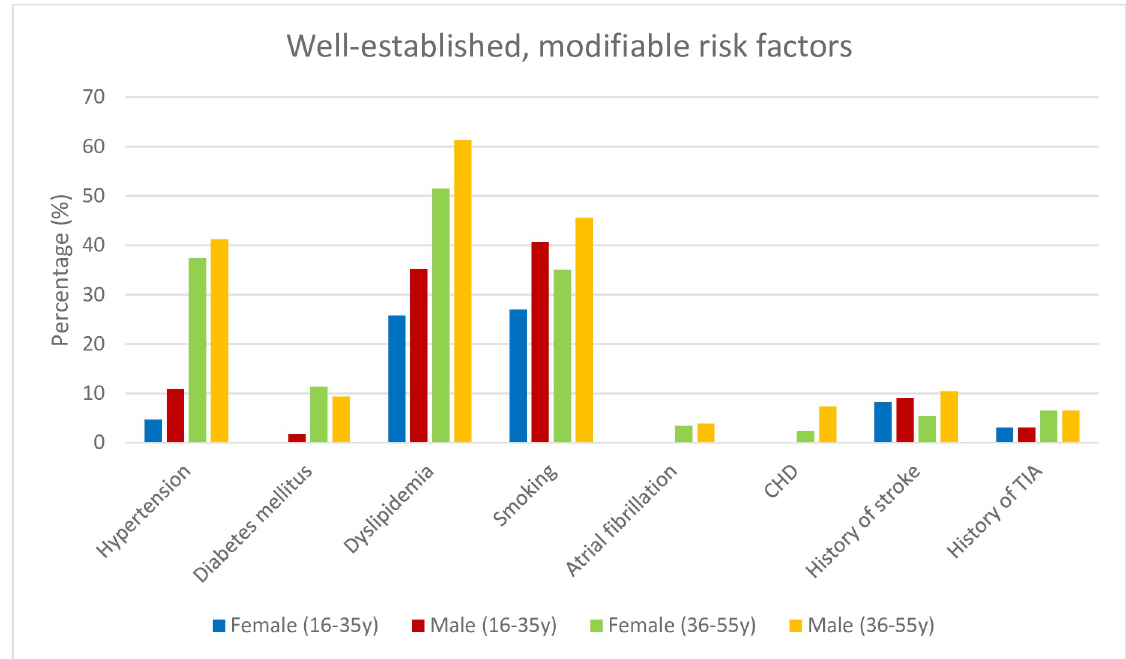
Fig 1. Y indicates years; CHD, coronary heart disease; TIA, transient ischemic attack.